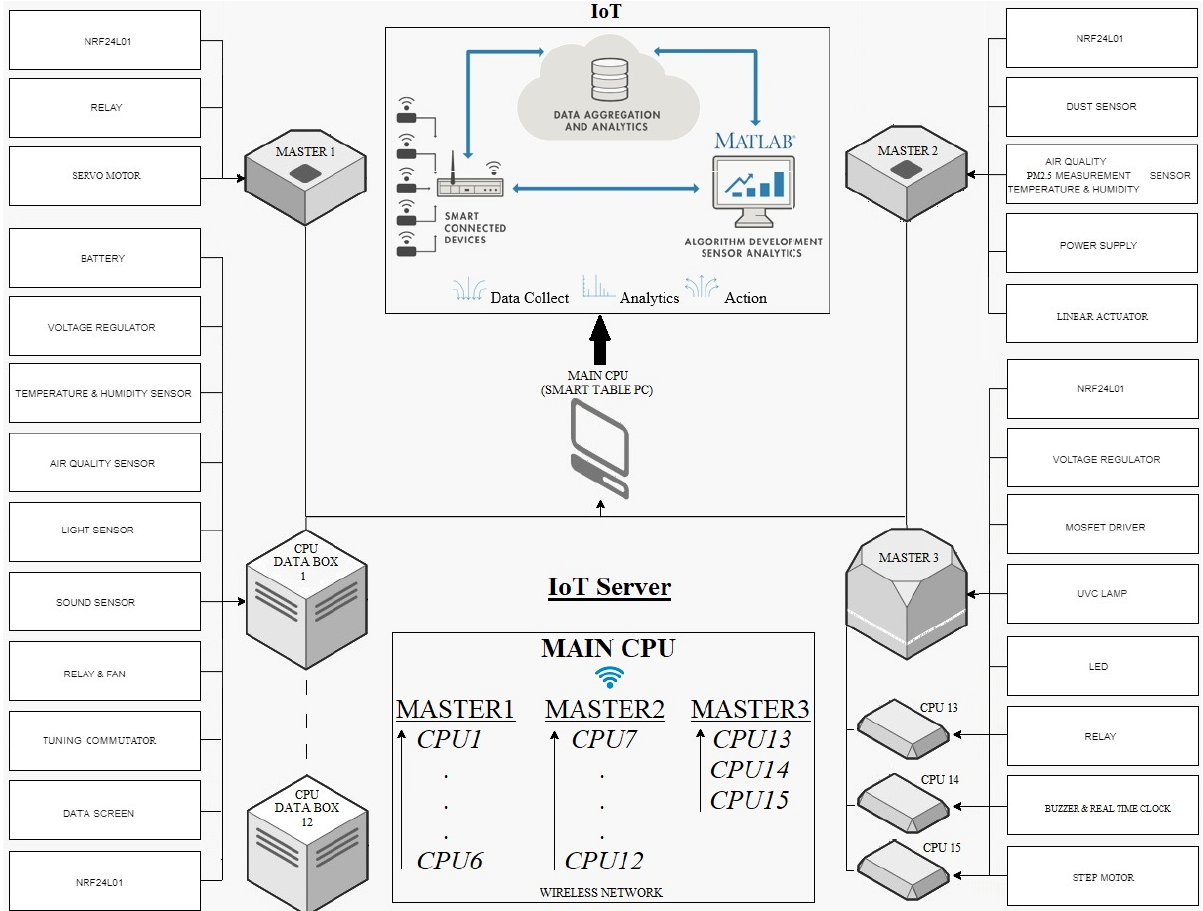
Figure 1. System structure of the SCI .